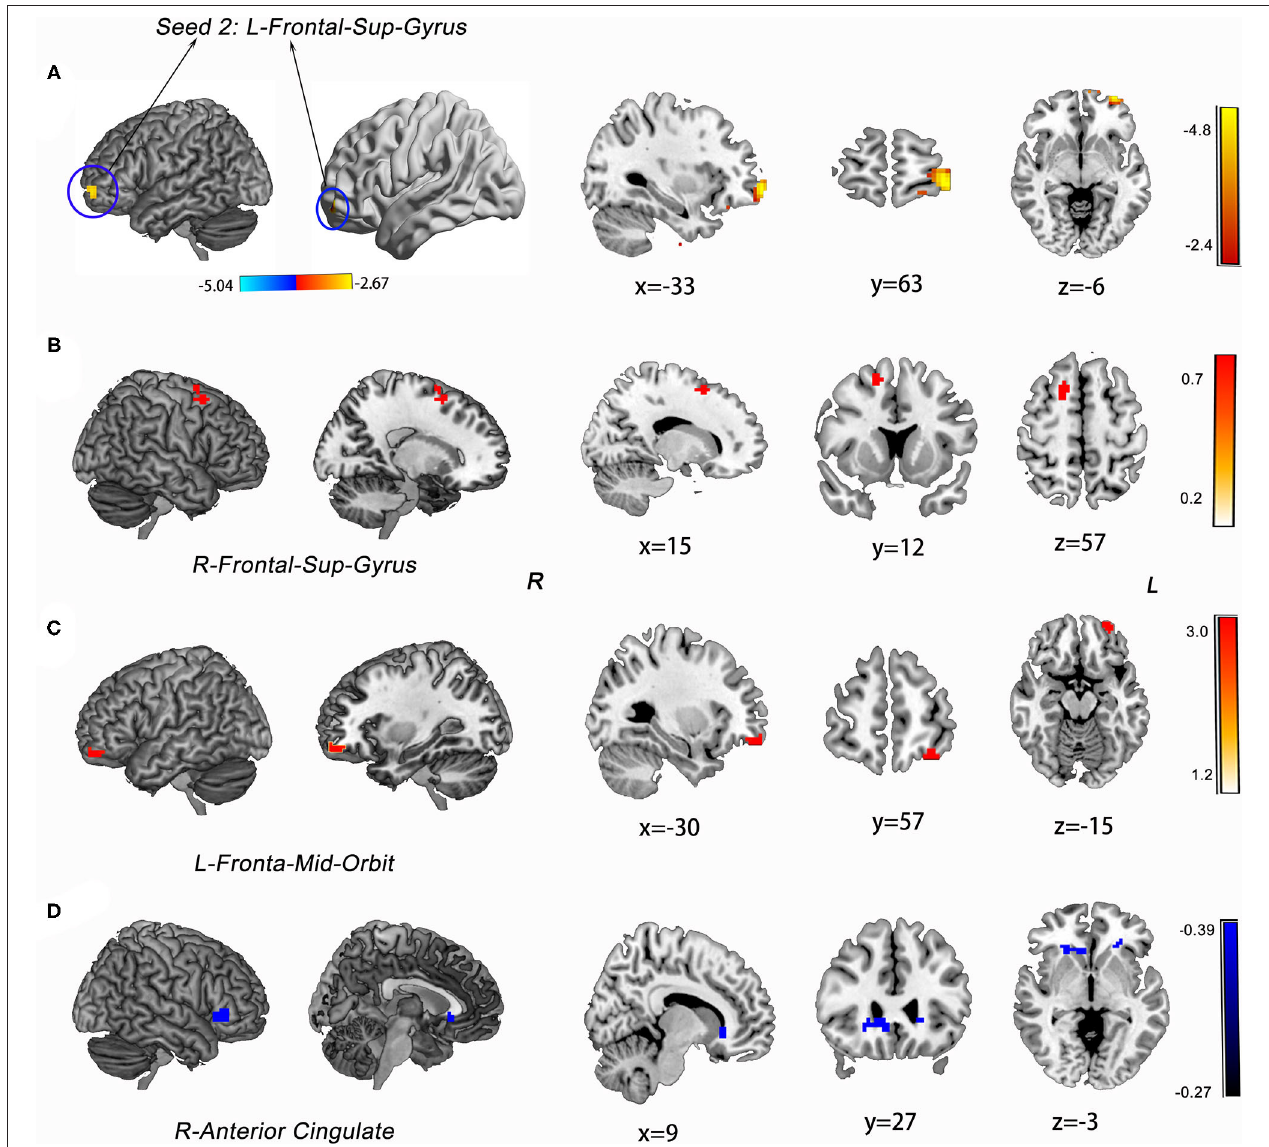
FIGURE 3 | Group differences in RSFC analysis using L-SFG as seed of ROIs and the statistical maps showing post hoc t-test results of RSFC analysis among the three groups. (A) The map of seed region of interest (ROI): left superior frontal gyrus (L-SFG, Peak MNI: − 33 63 − 6). (B) ATT group vs. NAT group; (C) NAT group vs. HC group; (D) ATT group vs. HC group; Red and blue denote increased and decreased RSFC, respectively, and the colour bars indicate the t -value from post-hoc analysis between each pair of